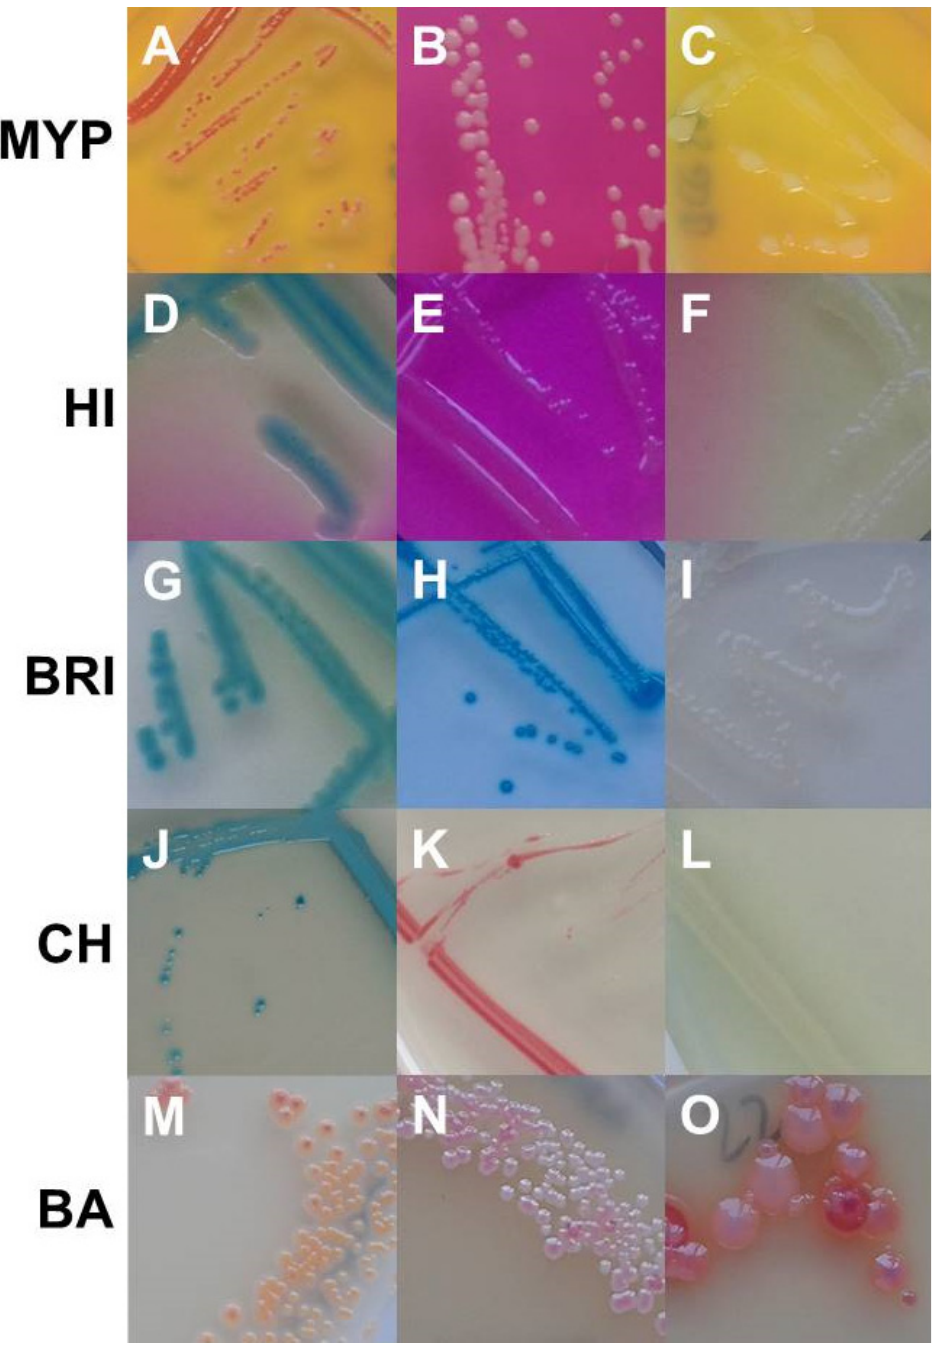
Figure 3. Growth of non-target organisms on Bacillus cereus selective media (from upper left to lower right). MYP agar: ( A )— Serratia marcescens (EGN 54); ( B )— Brochothrix thermospacta (EGP 2); ( C )— Bacillus stratosphericus (BG 28). ChromoSelect Bacillus agar: ( D )— Aeromonas hydrophila (EGN 5); ( E )— Acinetobacter baumannii (EGN 2); ( F )— Citrobacter freundii (EGN 9). Brilliance™ B. cereus agar: ( G )— Staphylococcus sciuri (EGP 13); ( H )— Serratia marcescens (EGN 54); ( I )— Pseudomonas fluorescens (EGN 45). CHROMagar™ B. cereus : ( J )— Morganella morganii (EGN 39); (K)— Enterococcus faecalis (EGP 5); ( L )— Providencia rettgeri (EGN 42). BACARA ® agar: ( M )— Staphylococcus haemolyticus (EGP 11); ( N )— Staphylococcus chromogenes (EGP 9); ( O )– Listeria monocytogenes (EGP 22) . Abbreviations: MYP— mannitol egg yolk polymyxin agar; HI—ChromoSelect Bacillus agar; BRI—Brilliance™ B. cereus agar; CH—CHROMagar™ Bacillus cereus ; BA—BACARA ® agar.